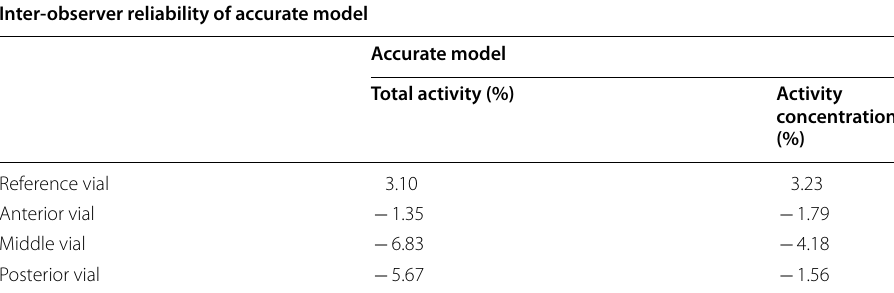
Table 6 PET errors for total activity and activity concentration measured by the second observer using the accurate model µ map Inter-observer reliability of accurate model Accurate